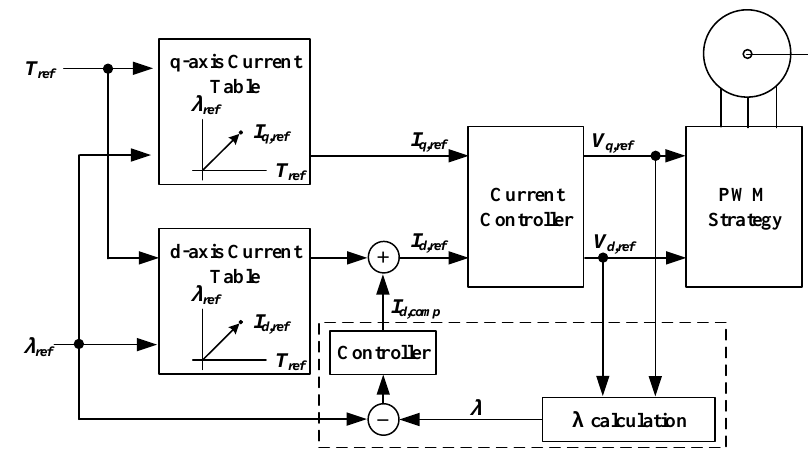
Figure 4. Control block diagram for driving the IPMSM.